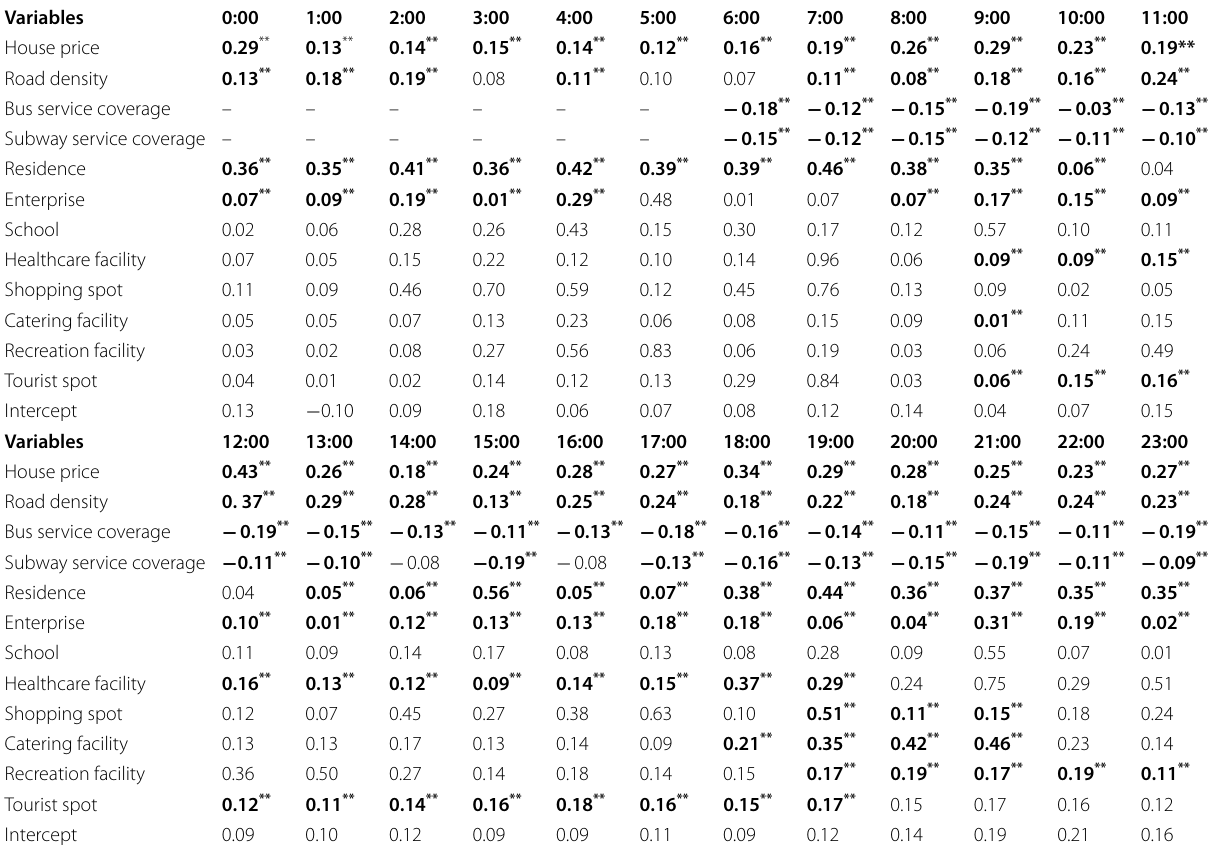
Table 3 Coefficients of multiple linear regression in different